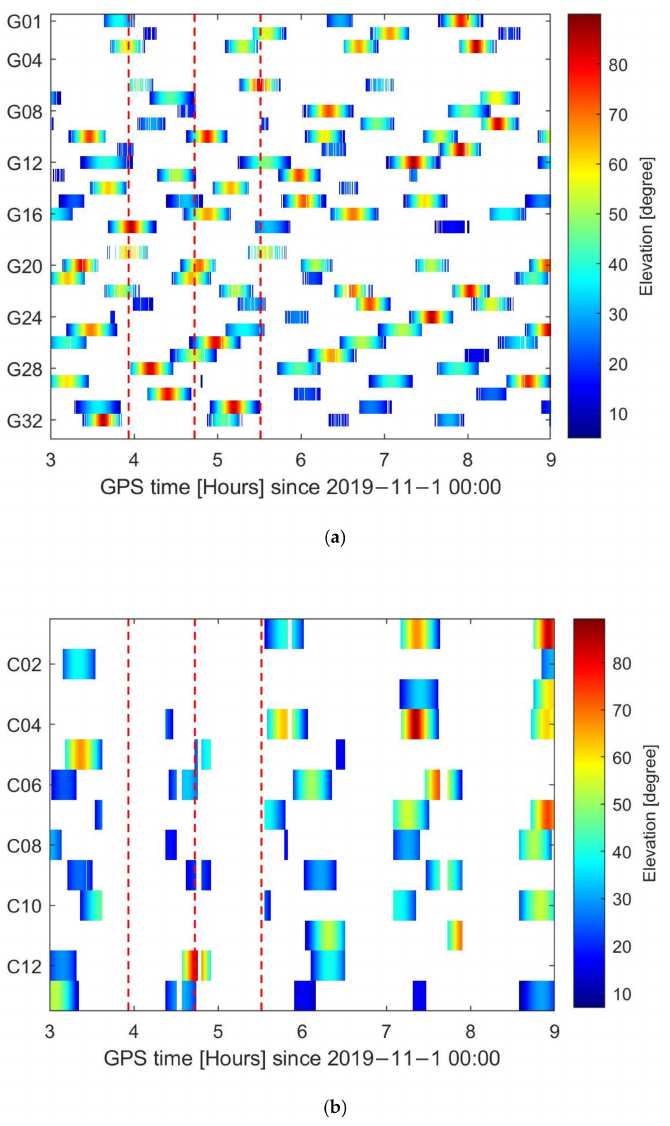
Figure 7. Duration and common elevation of continuous carrier phase tracking arcs for navigation satellites of the two TH-2 satellites: ( a ) GPS satellites; ( b ) BDS2